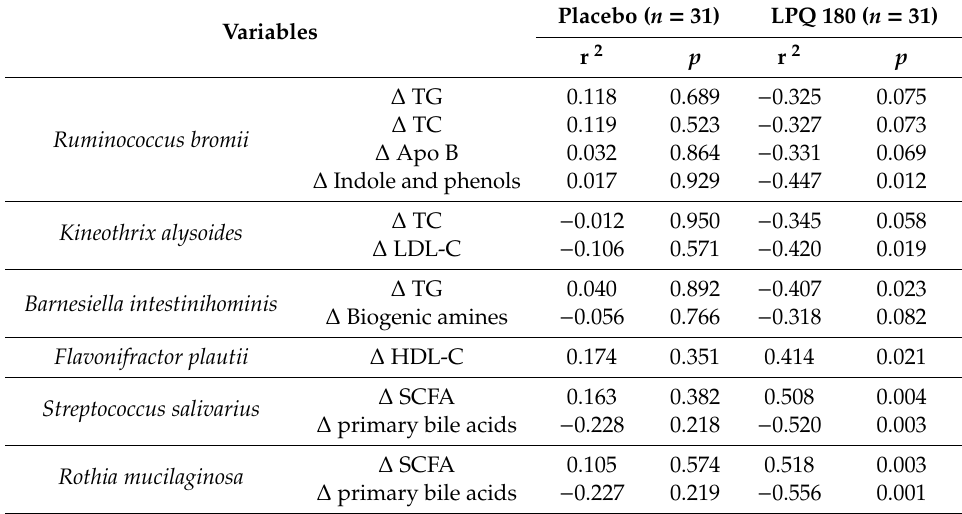
Table 4. Correlation between baseline levels of the intestinal microbiome and changes in blood lipid markers or fecal metabolites for 12 weeks 1 .